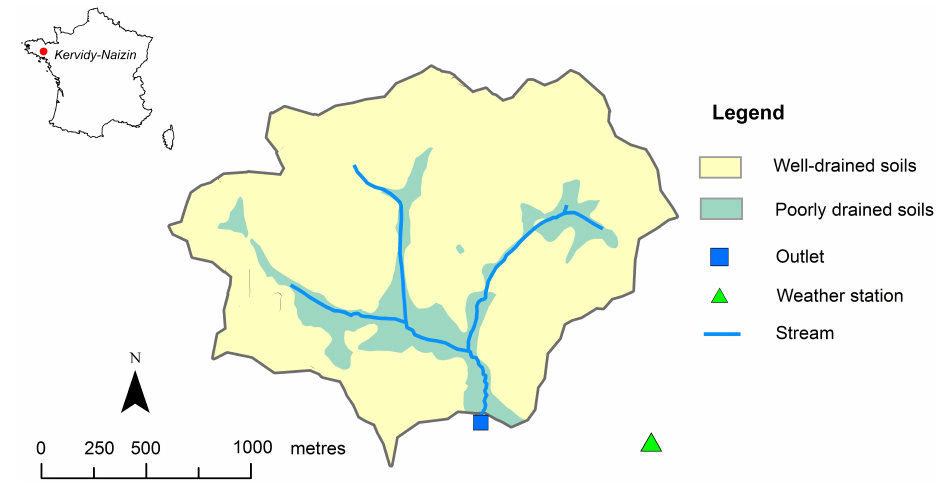
Figure 1. Soil drainage classes in the Kervidy–Naizin catchment (Curmi et al.